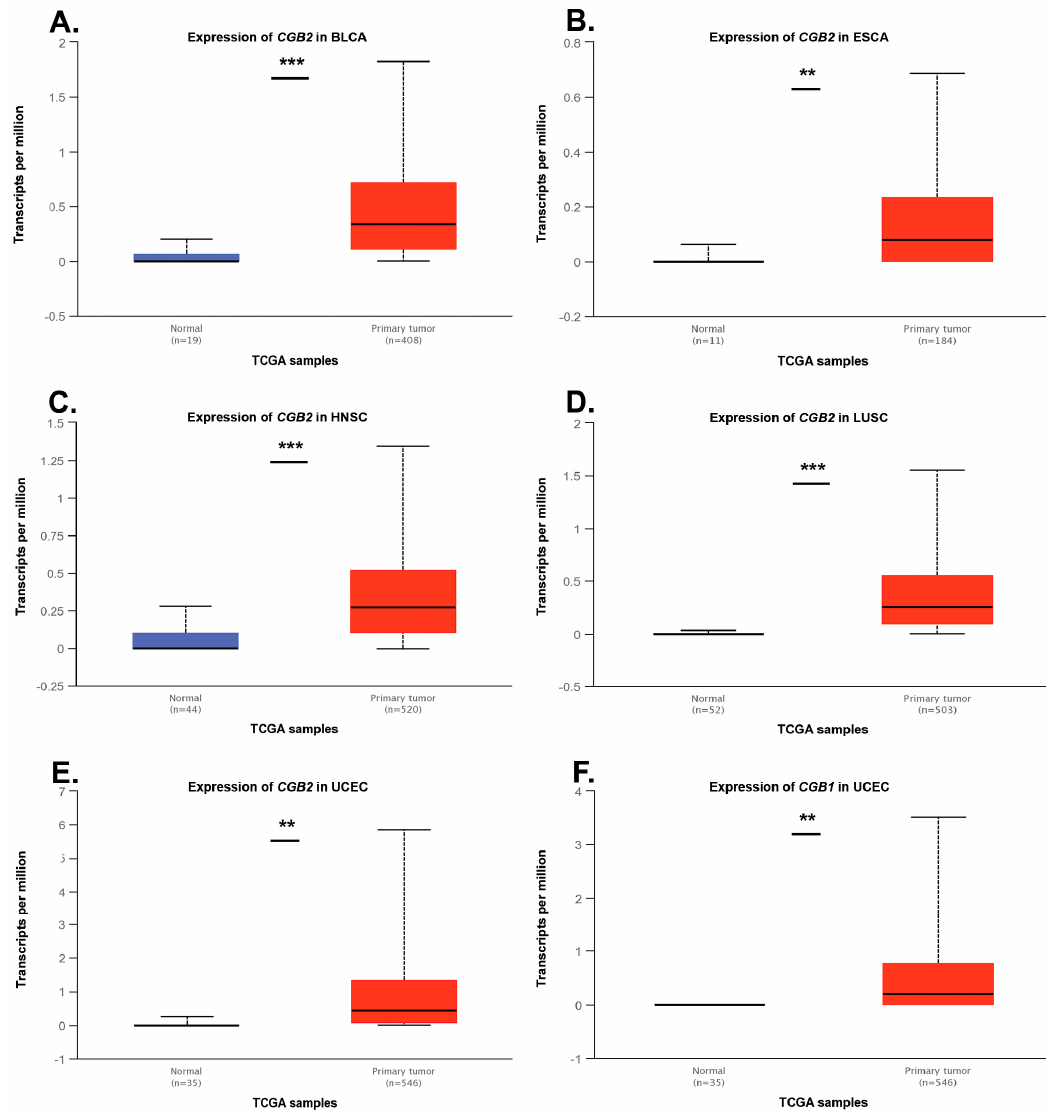
Figure 3. Expression levels of CGB1 and CGB2 in primary tumor samples and corresponding healthy tissues according to data deposited in the UALCAN database. ( A ) Expression of CGB2 in BLCA, ( B ) expression of CGB2 in ESCA, ( C ) expression of CGB2 in HNSC, ( D ) expression of CGB2 in LUSC, ( E ) expression of CGB2 in UCEC, ( F ) expression of CGB1 in UCEC. ** p ≤ 0.01; *** p ≤ 0.001 .